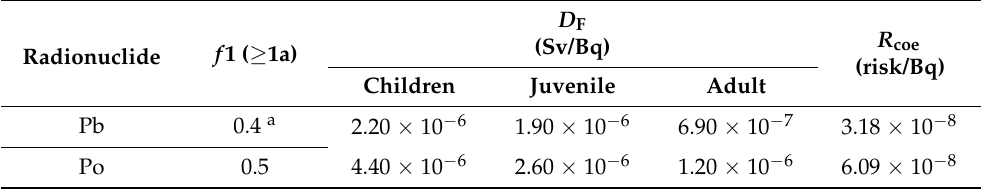
Table 2. Dose conversion factors for ingestion ( D F ), the risk coefficients ( R coe ), and gastrointestinal absorption fractions ( f 1 ) for 210 Pb and 210